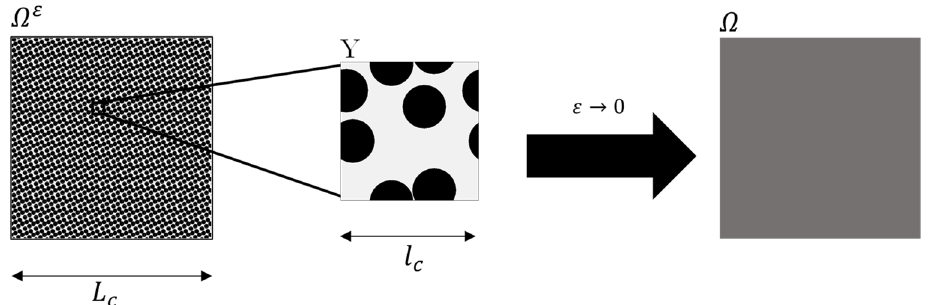
Figure 1. Conceptualization of the asymptotic